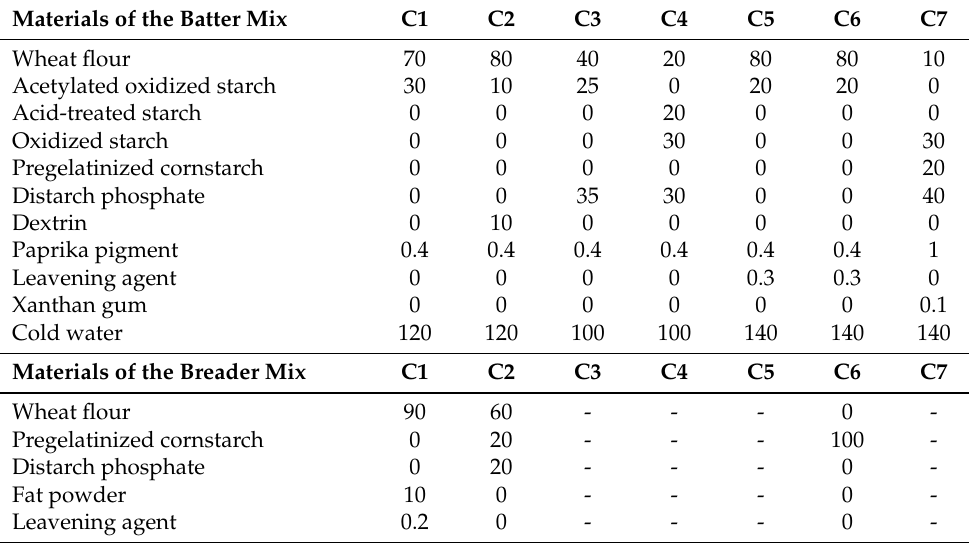
Table 1. Materials of the batter and breader mixes. The unit is